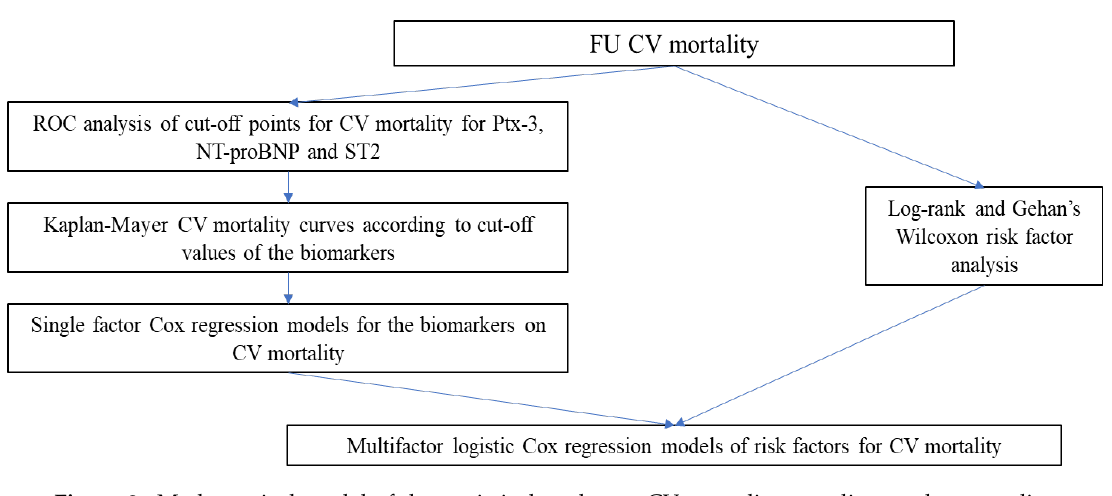
Figure 2. Mathematical model of the statistical analyses. CV mortality—cardiovascular mortality,